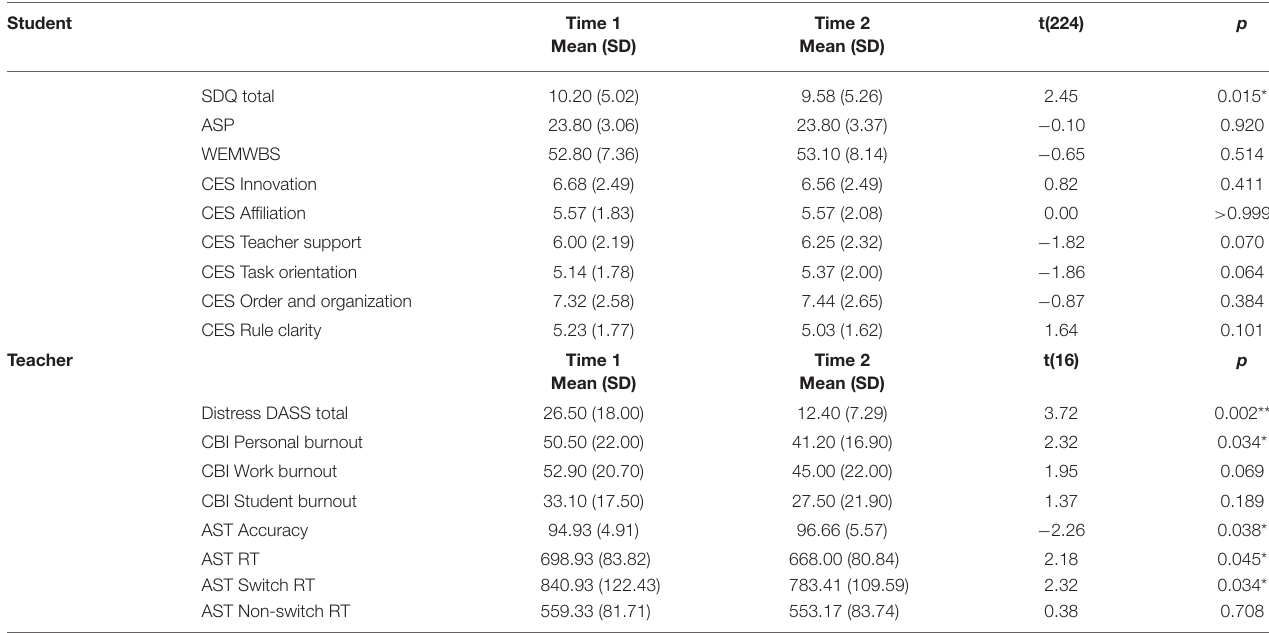
TABLE 2 | Time 1 (pre-intervention) and Time 2 (post-intervention) means and SDs for student and teacher measures, with corresponding pairwise t -statistics and p -values. Student